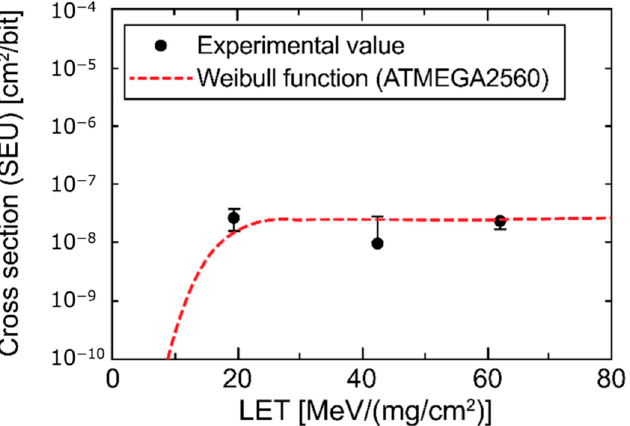
Figure 10. LET–SEU upset cross-section characteristic curve graph (microcomputer: ATmega2560).